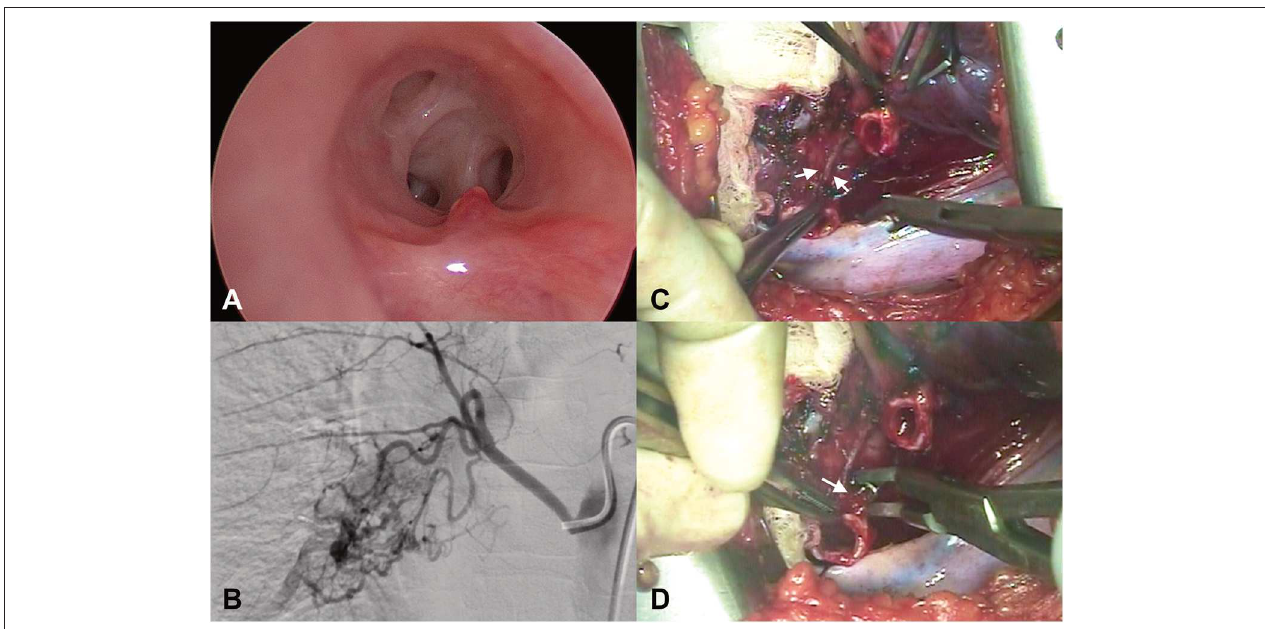
FIGURE 1 | (A) Bronchoscopy showed a polypoid lesion over the right bronchus intermedius. (B) Bronchial artery angiography showed multiple engorged and tortuous feeding vessels to the lesion. (C,D) Intraoperative photographs showing discrete engorged feeding arteries (arrows) on the wall of the bronchus intermedius.